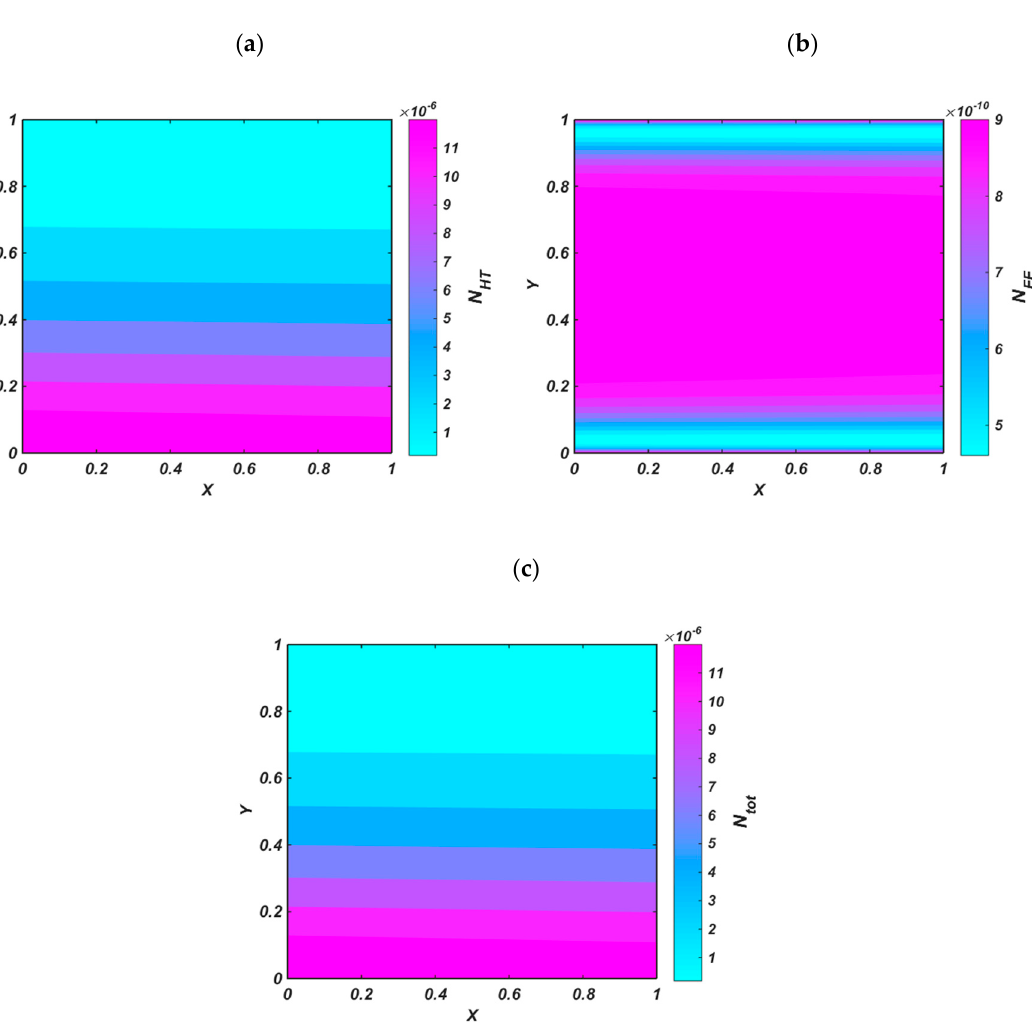
Figure 8. Entropy generation counters: ( a ) heat transfer, ( b ) fluid friction and ( c ) total. Energies 2020 , 13 , x FOR PEER REVIEW